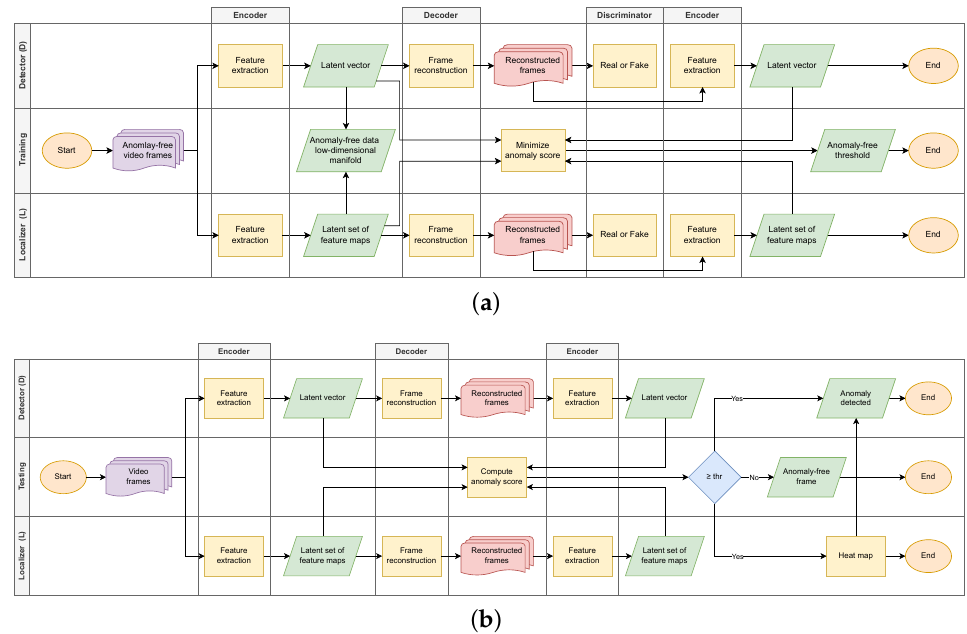
Figure 2. In ( a , b ), the detailed workflows required for detecting and localizing anomalies in RGB videos during the training and testing phases,